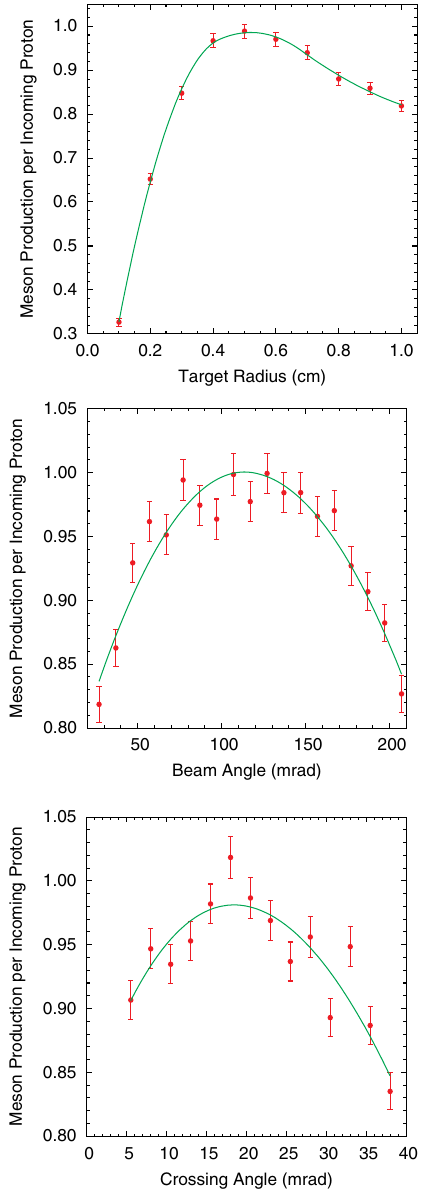
FIG. 4. Meson production as a function of target radius (top), proton beam angle (middle), and beam-target crossing angle (bottom). Data points represent meson production generated from 10 5 incoming 50-GeV protons. Curves are least-squares fits to this data.